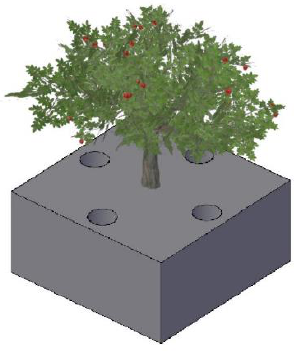
Figure 1. Field layout.